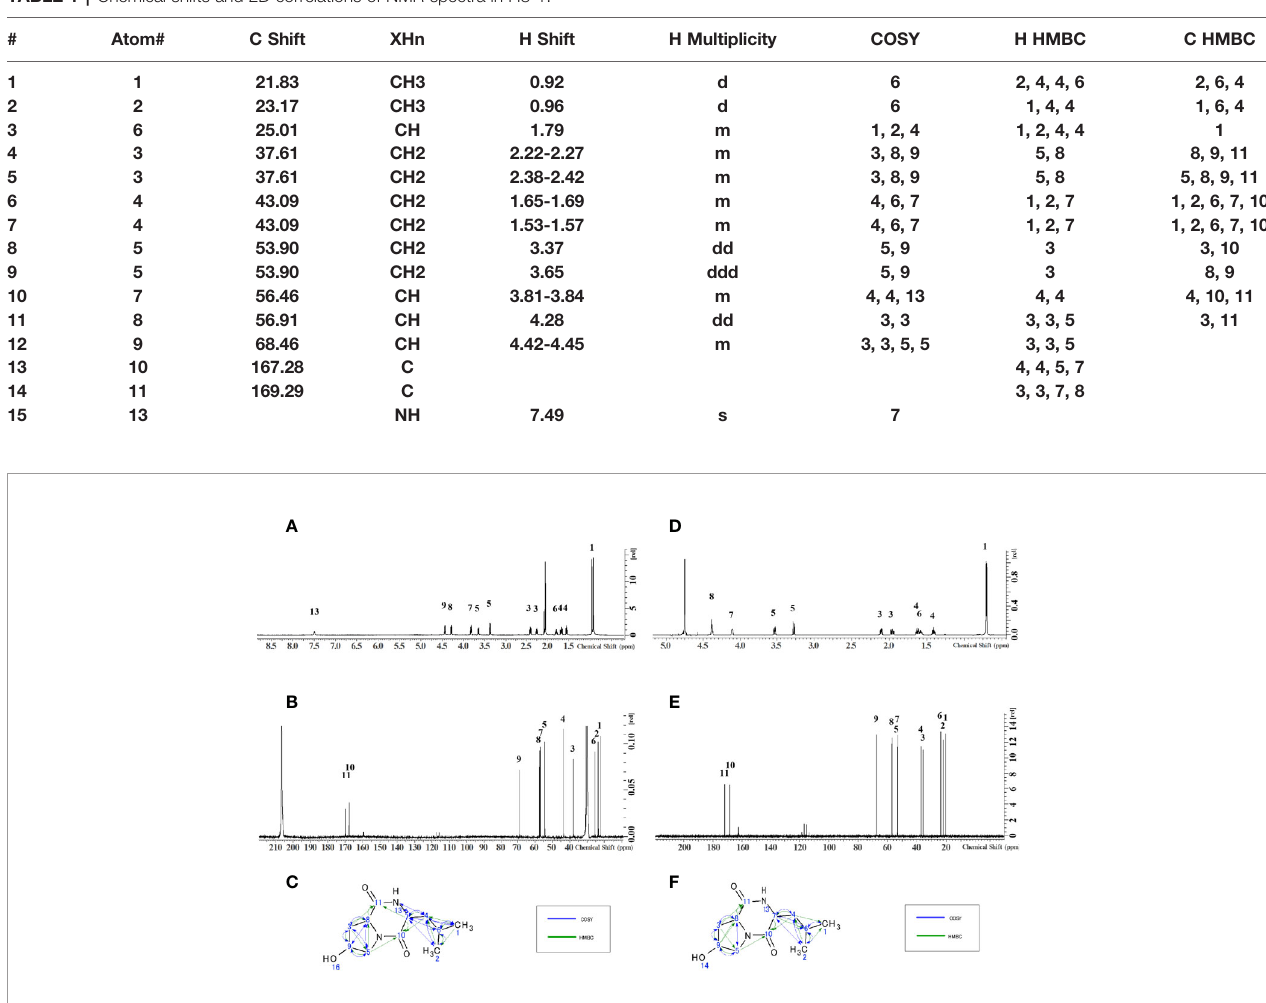
TABLE 1 | Chemical shifts and 2D correlations of NMR spectra in H8-1.